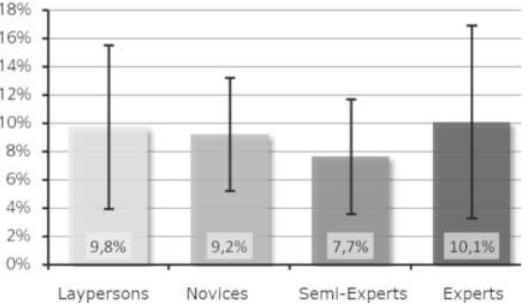
Figure 8. Percentage of fixations on basic features (Moses).